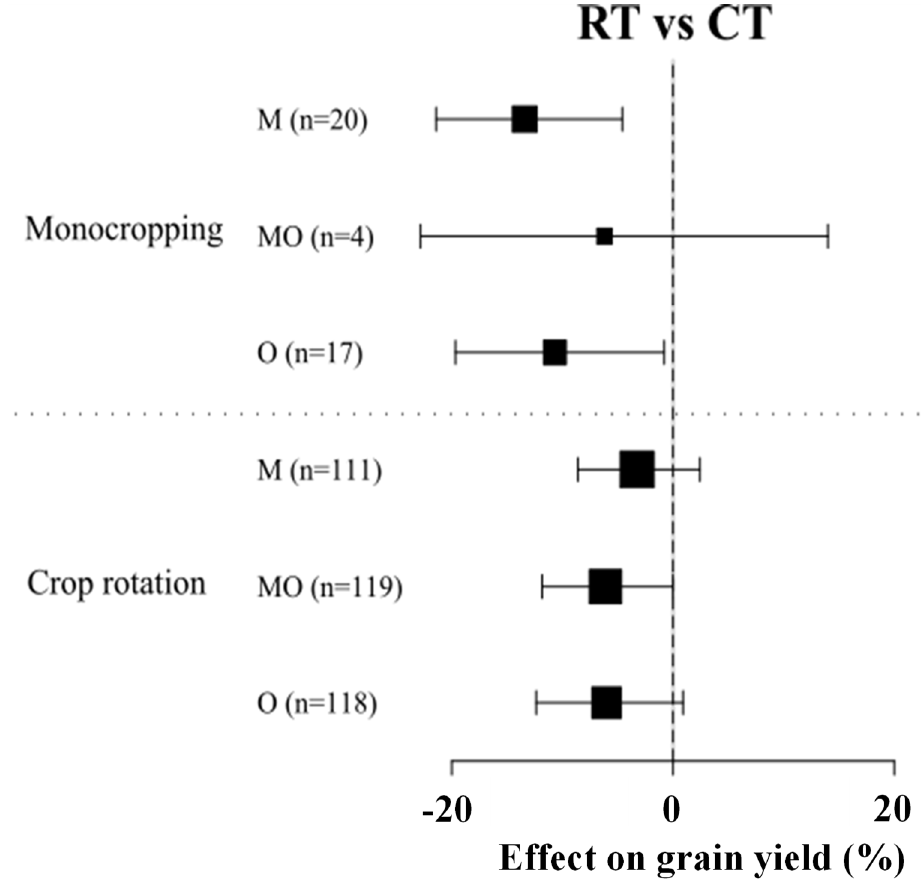
Figure 4. The response of reduced tillage vs. the conventional tillage practices (RT vs. CT), under different nutrient sources; inorganic (M), organic (O) and inorganic + organic (MO), for different cropping systems (monoculture vs. rotation) expressed as the average effect on grain yield (%). “n” refers to the number of observations for each subgroup. The vertical line represents the null hypothesis [ln (RR) = 0]. The squares are the point estimate of effect size. The horizontal lines are the associated 95% confidence interval for the population parameter.